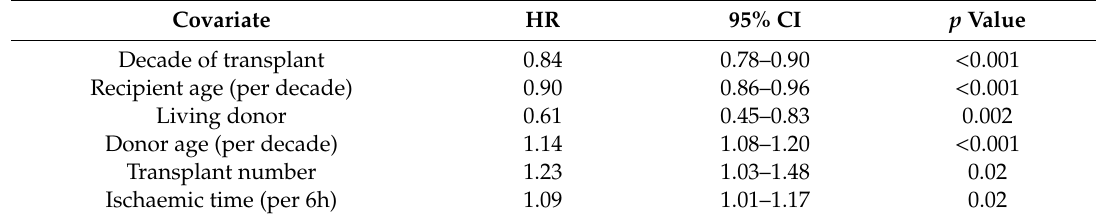
Table 2. Factors associated with death-censored graft survival in all recipients on a multivariate analysis.